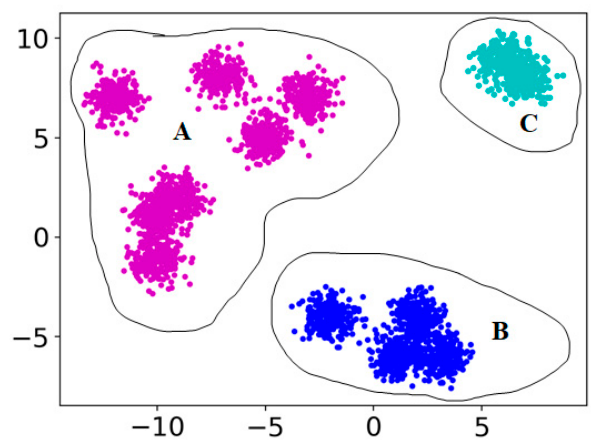
Figure 8. Fault feature visualization.